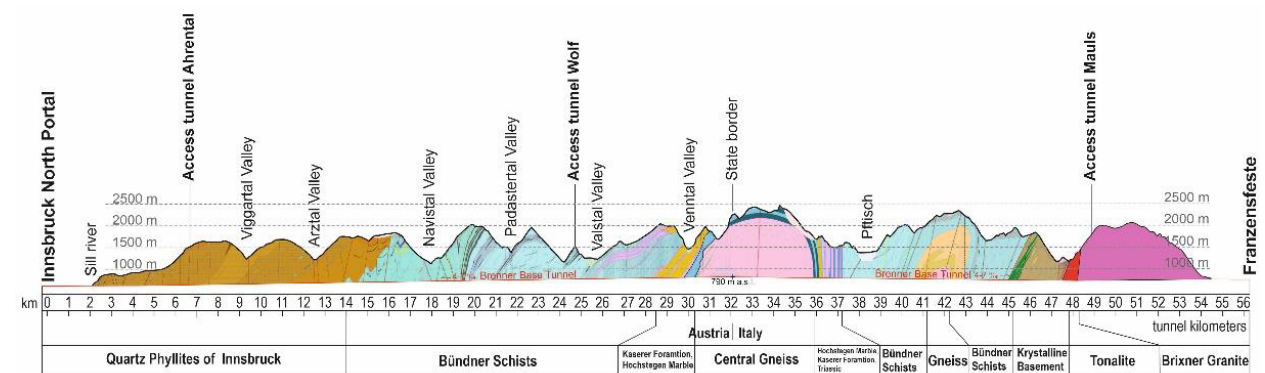
Figure 2. Geological longitudinal section of the Brenner Base Tunnel, modified from [7].